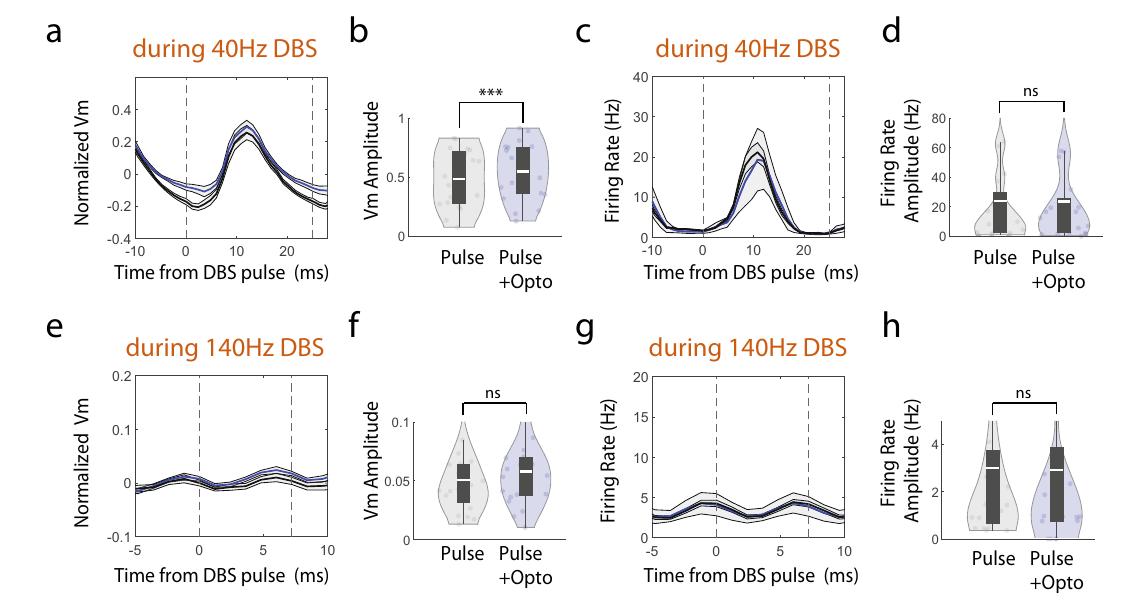
Fig. 6 | Individual electrical pulse evoked Vm and fi ring rate changes are dif- ferentially modulated by optogenetic depolarization. a Population-averaged Vm aligned to individual electrical pulses during 40Hz DBS with simultaneous optogenetic CoChR activation (blue line) and without CoChR activation (black line).DashedlinesindicatetheonsetofindividualDBSelectricalpulsetimes.Pulse- averaged Vm was fi rst computed for each neuron and then averaged across neu- rons. Normalized Vm was then computed by subtracting the mean of the popula- tion pulse averaged Vm during the 10ms (40Hz DBS) or 5ms (140Hz DBS) time period before pulse onset. Shaded area represents SEM. b Electrical pulse evoked